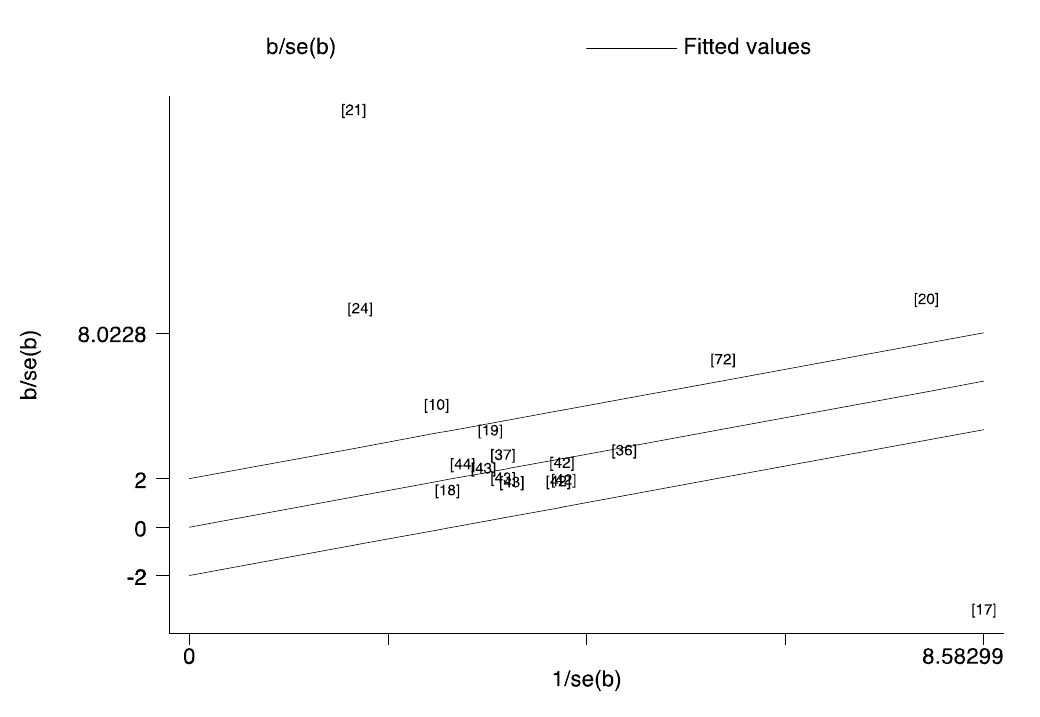
Figure 13. Galbraith plot for the contribution of results from the different studies [10,17–21,24,36,37,42–44,72] about risk for ferritin to the heterogeneity. This analysis was based on the relevant data listed in Table 1 and the number orders in the plot were same to the reference list.